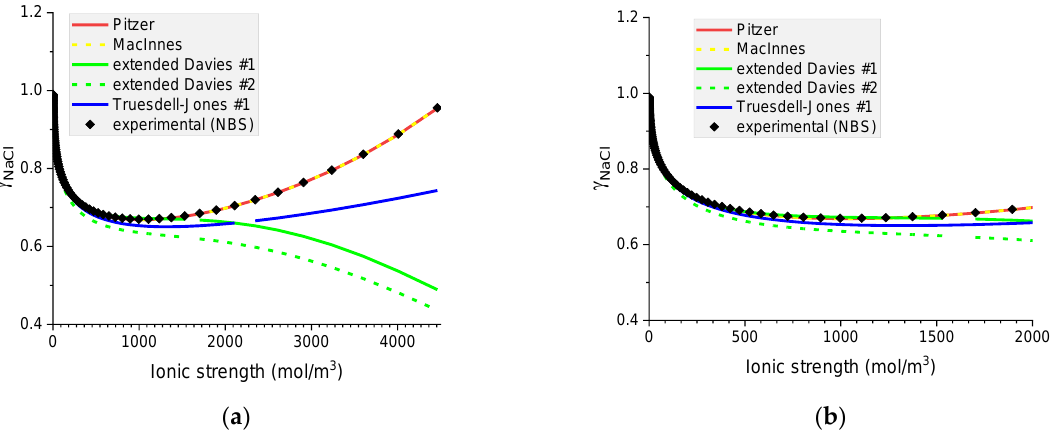
Figure 5. Molar mean ionic activity coefficients in aqueous NaCl for ( a ) concentrated, ( b ) dilute solutions. Comparison of calculated activity coefficients based on the Pitzer, MacInnes, extended Davies, and Truesdell – Jones models with experimental results (NBS) at 25 °C.